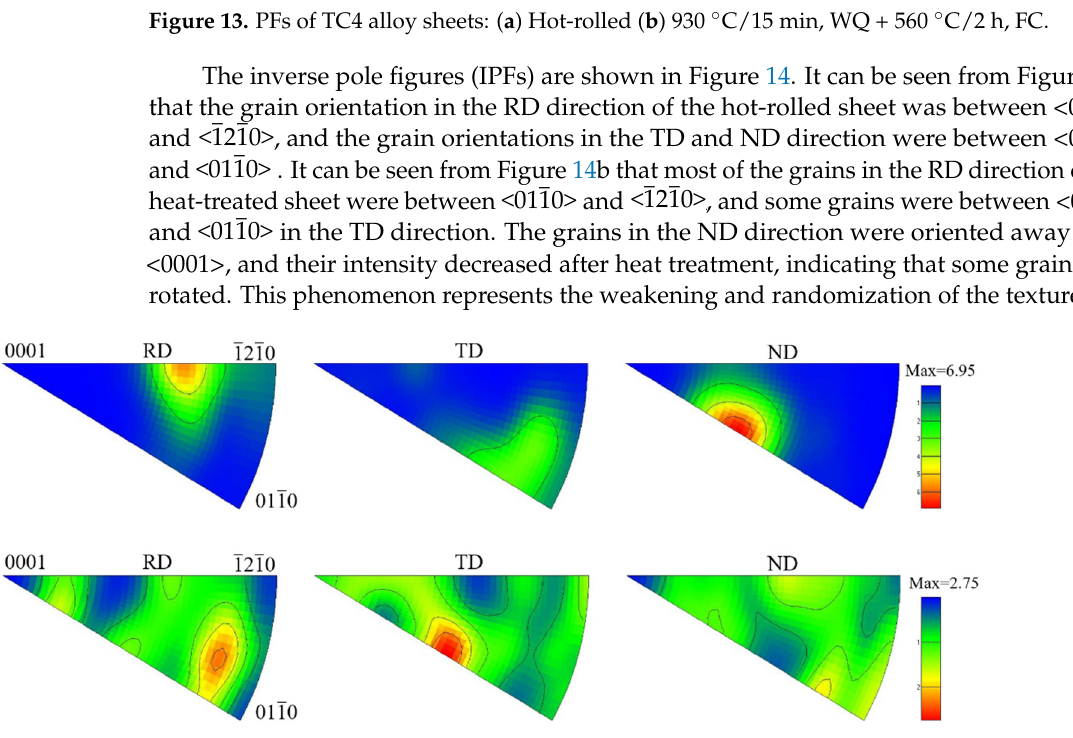
Figure 14. IPFs of TC4 alloy sheets: ( a ) Hot-rolled ( b ) 930 °C/15 min, WQ + 560 °C/2 h, FC.